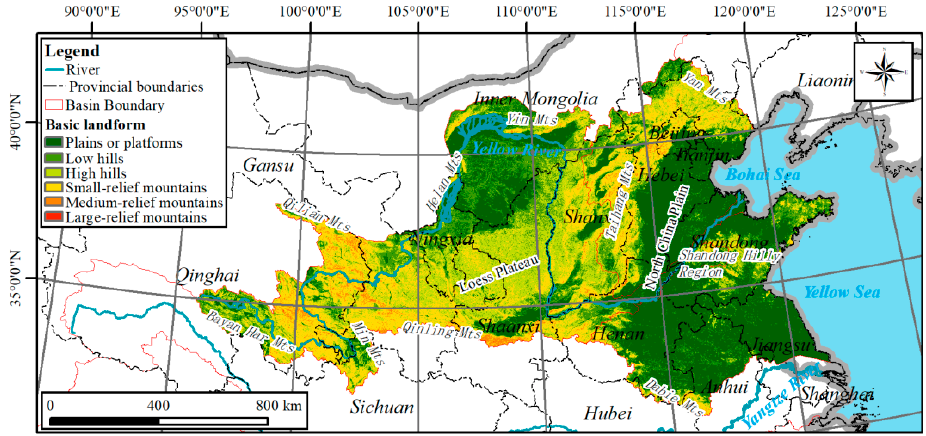
Figure 2. Landforms of the GYRR. The mountainous areas occupy about two-thirds of the GYRR. The cultural exchange in the GYRR is convenient, and forms the unique Yellow River civilization.